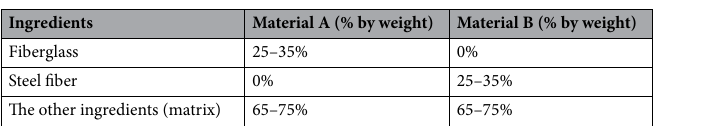
Table 1. The considered modification of the composition of materials 9,20